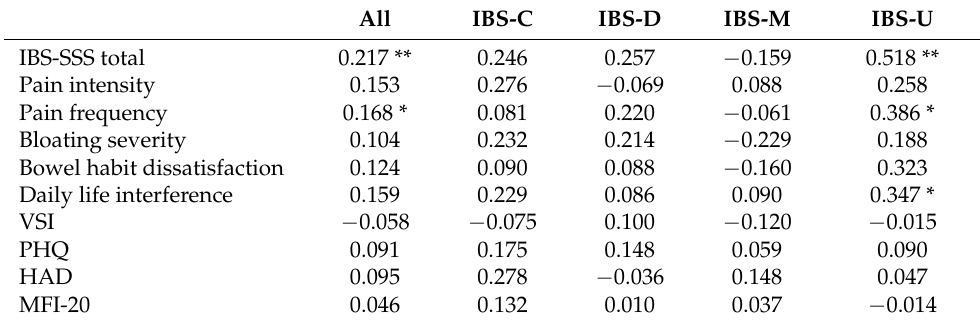
Table 3. Spearman correlation between quartiles of (energy adjusted) total FODMAP intake and IBS symptom severity and other symptoms among women divided into different IBS